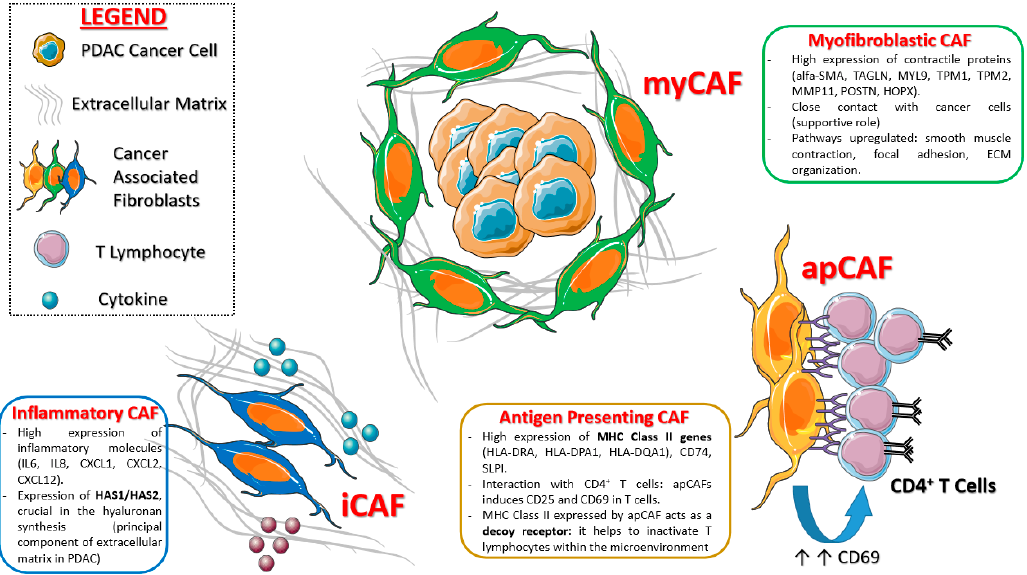
Figure 3. Main CAF sub-types and related functions postulated in pancreatic cancer. Created with Servier Medical Art.